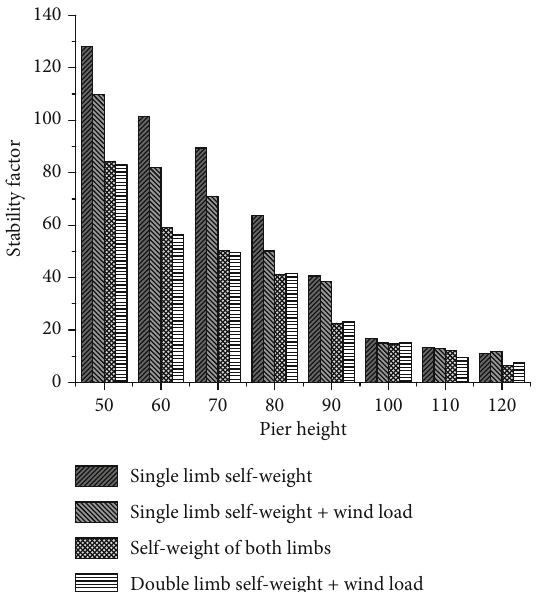
Figure 8: Change of the global stability coe ffi cient of rigid-frame bridge with pier height.